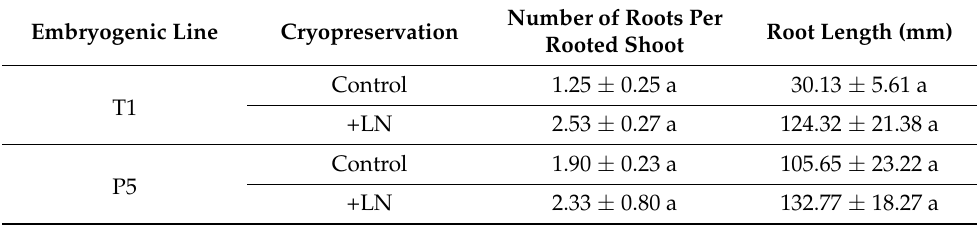
Figure 4. Rooting percentage of olive shoots derived from control and cryopreserved embryogenic cultures of the lines T1 and P5. Different letters indicate significant differences by the R × C test, with a significance level of 0.05. Table 3. Effect of cryopreservation on the rooting capacity of olive shoots derived from control and cryopreserved embryogenic cultures of the lines T1 and P5. Data represent the mean ± SEM. Different letters indicate significant differences by the LSD test, with a significance level of 0.05.